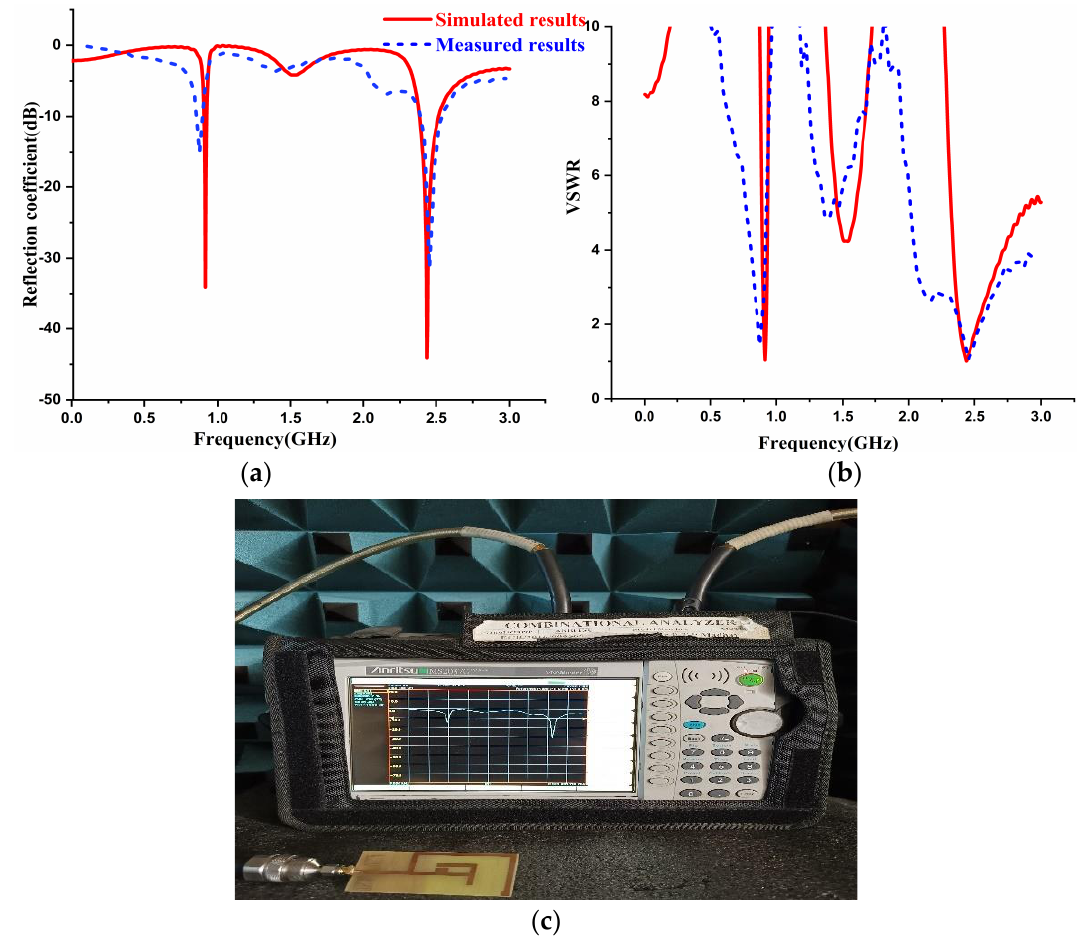
Figure 13. Simulated and Measured Results of Antenna without AMC Backing ( a ) Reflection Coefficient, ( b ) VSWR, ( c ) Snapshot of antenna results using VNA.